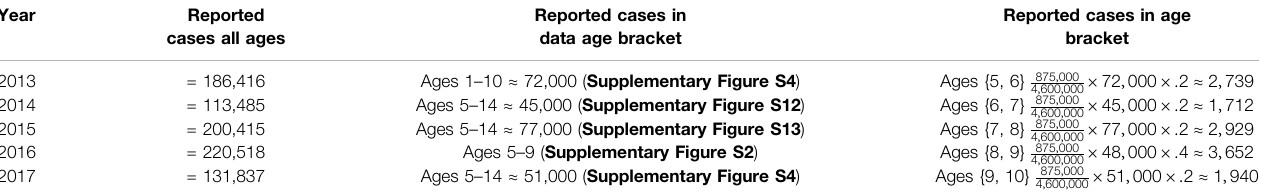
TABLE 4 | The reported number of infected in the population of vaccinated children, 2013 – 2017.